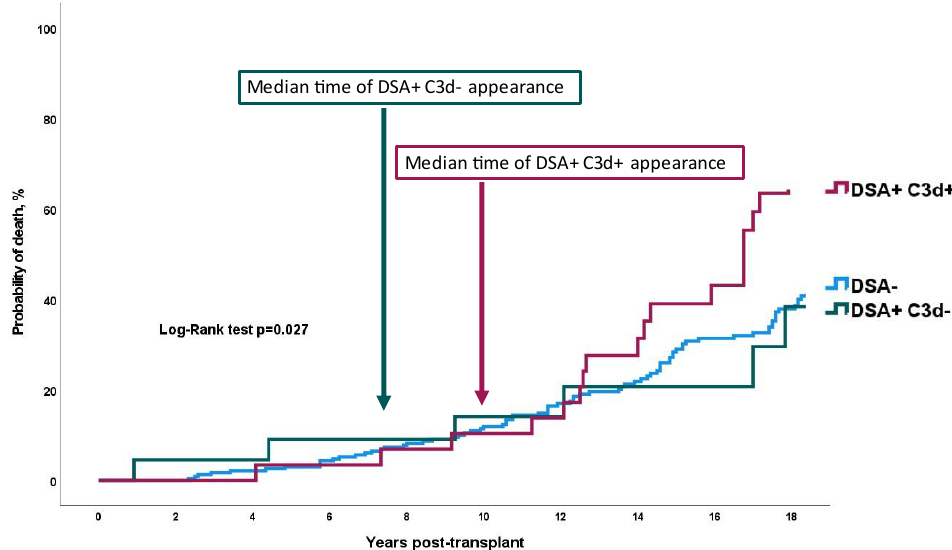
Figure 4. Probability of mortality according to DSA and C3d status. Log rank test p = 0.027. De novo C3d-binding DSA were associated with long-term mortality whereas non-complement-binding do- nor-specific anti-HLA antibodies were not. DSA = Donor-specific anti-HLA antibodies; DSA+C3d+ = complement-binding donor-specific anti-HLA antibodies; DSA+C3d − = non-complement-binding donor-specific anti-HLA antibodies.